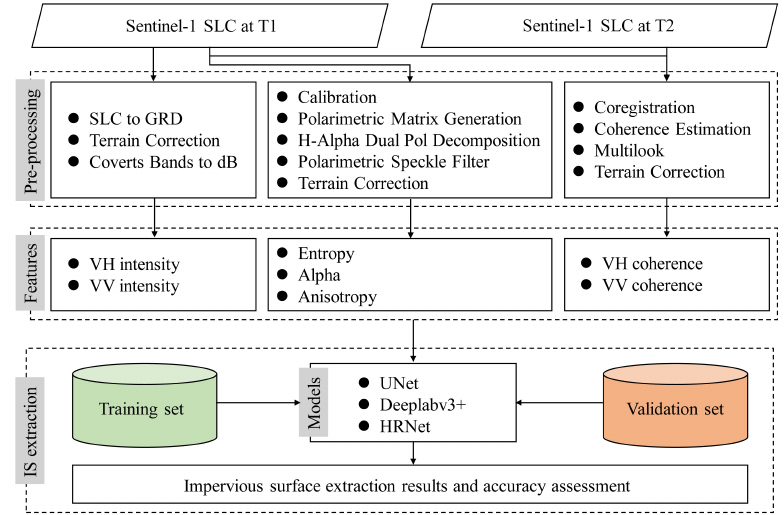
Figure 2. The overall framework of this